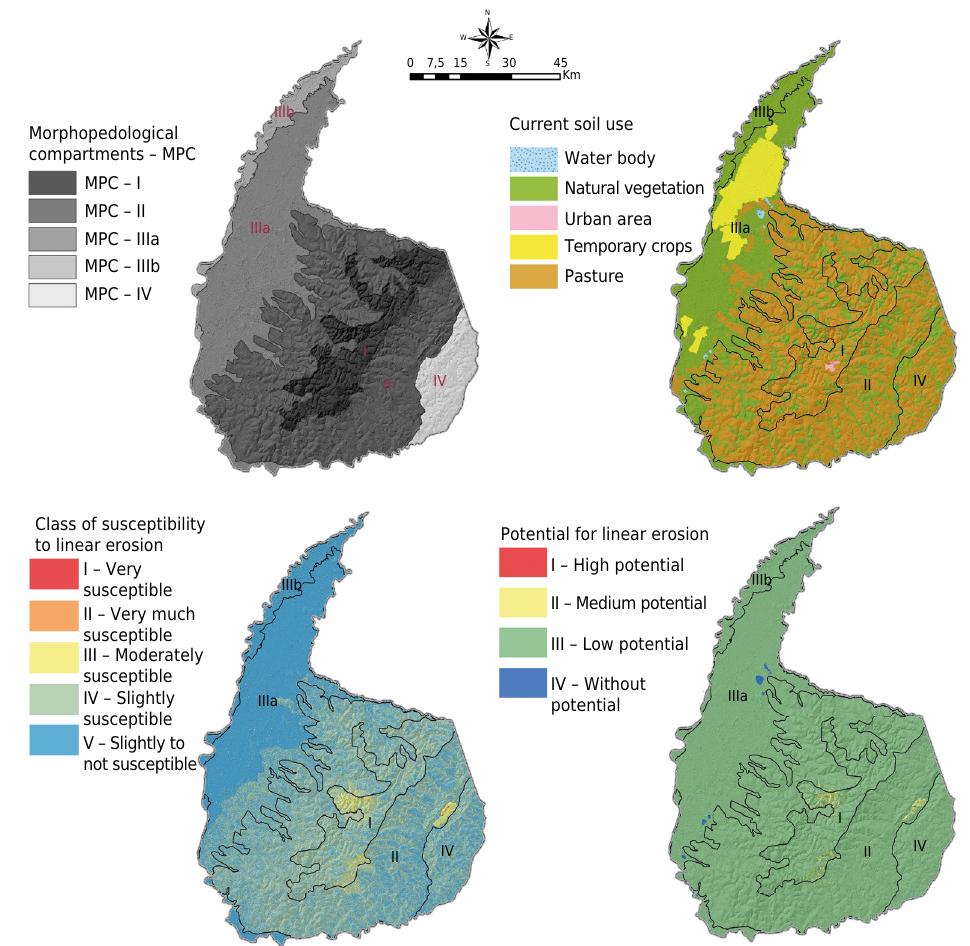
Figure 5. Morphopedological compartment maps, current use, susceptibility to erosion, and erosion potential in the municipality of São Miguel do Araguaia, state of Goiás,